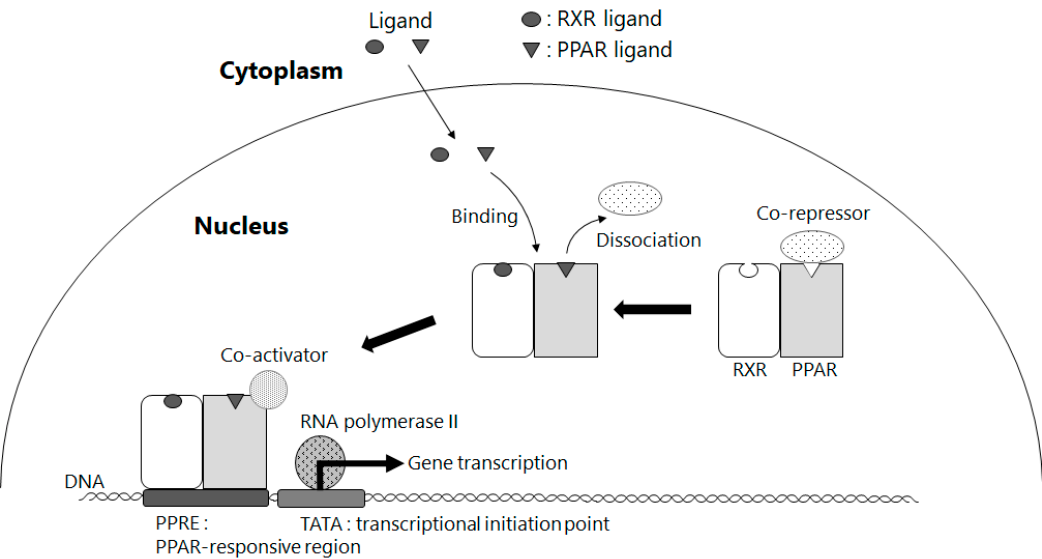
Figure 6. Expression mechanism of PPARs function by either RXR or PPAR ligands: RXR or PPAR ligands bind to and activate their corresponding receptors inside the nucleus, and then heterodimerized RXR/PPAR transcription factor binds to its responsive element in DNA and related gene transcription begins. RXR: retinoid X receptor, PPAR: peroxisome proliferator activated receptor, PPRE: peroxisome proliferator response element.